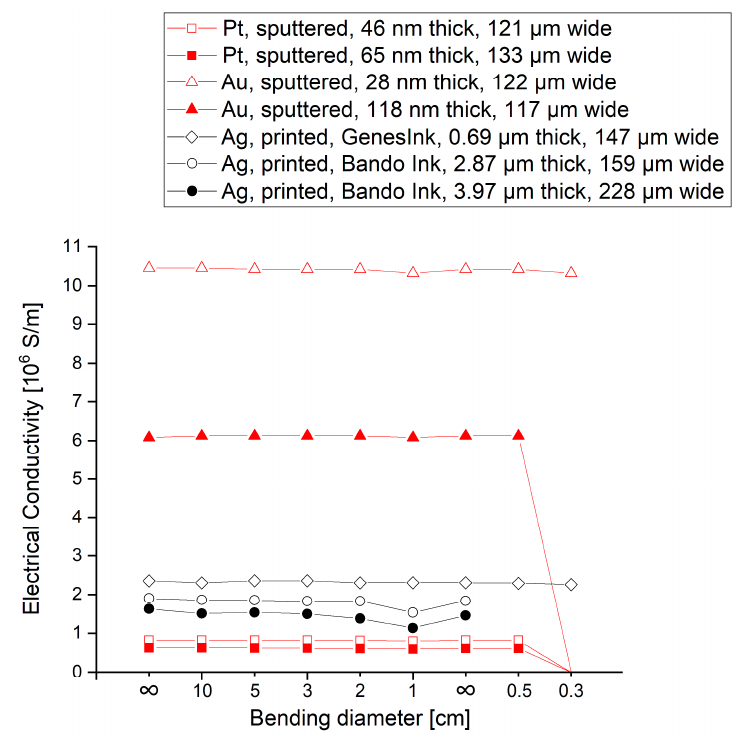
Figure 6. Electrical conductivities of the transferred metal meanders for different bending diameters.